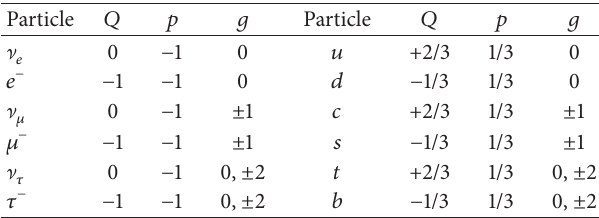
Table 3: GM additive quantum numbers for leptons and